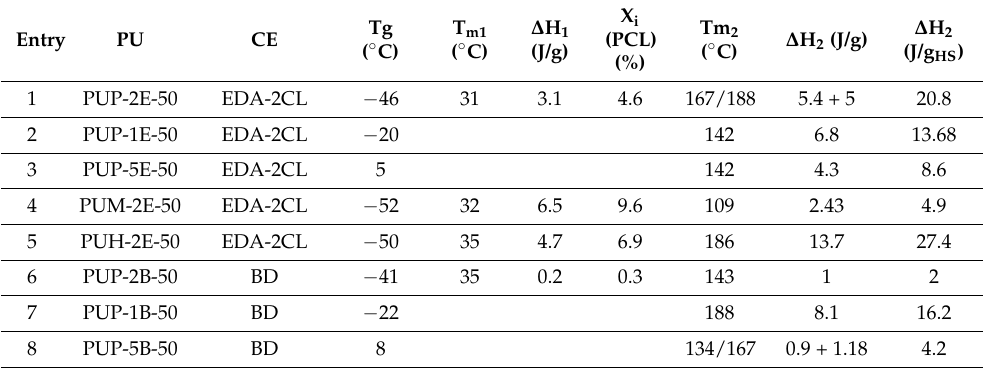
Table 2. Thermal properties of the synthesized